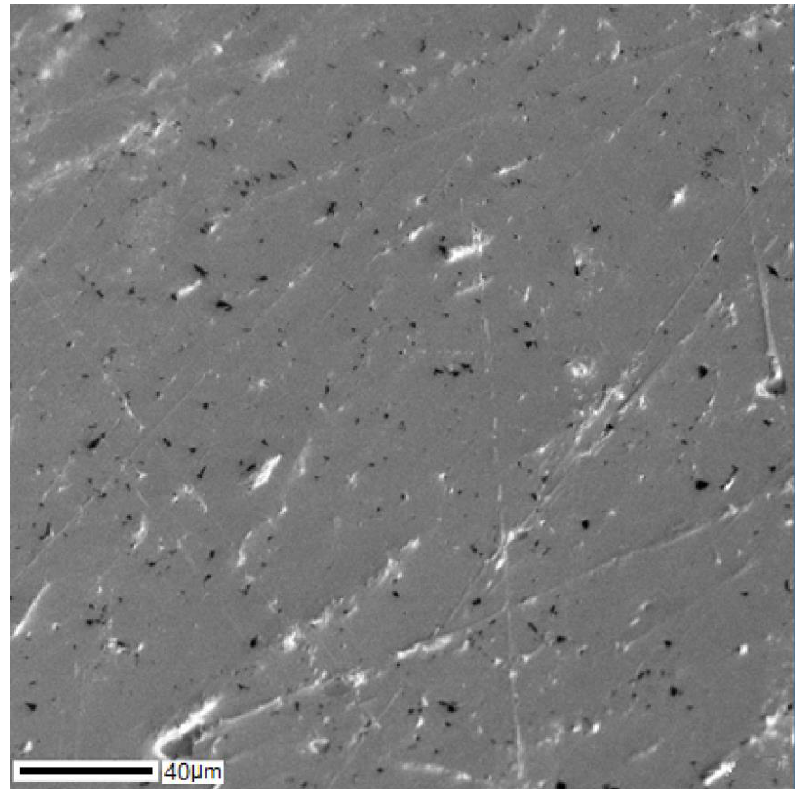
Figure 8. The structure of the Ti–28Nb–5Zr rod obtained using SEM.